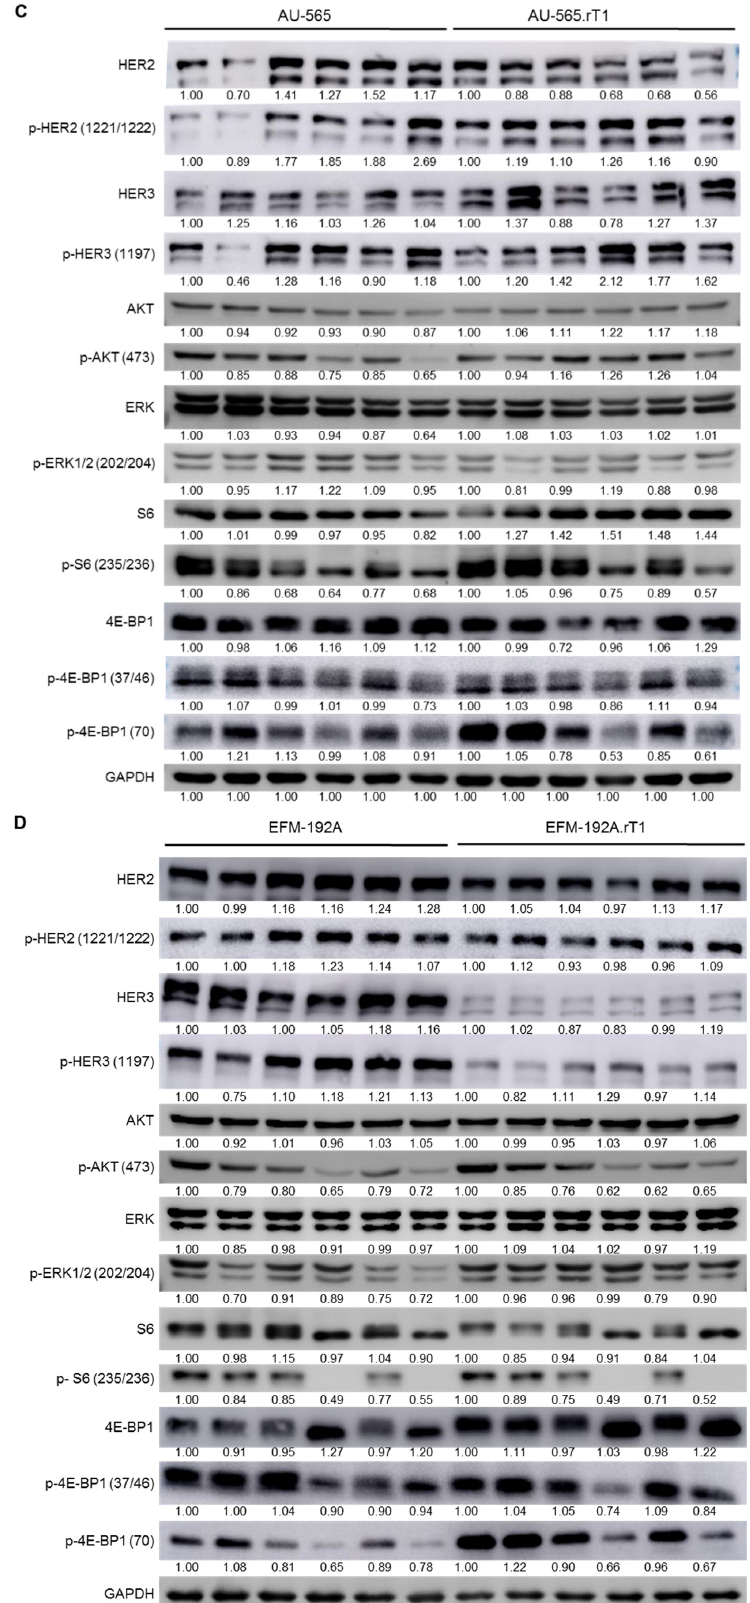
Figure 5. ( A ) Inhibition of p-S6 (Ser235/236) in trastuzumab-sensitive and -resistant BT-474 cells treated with a combination of trastuzumab and TAK-228. Sensitive and trastuzumab-resistant cells were treated for 24 h with DMSO, 15 µg/mL trastuzumab (T), 5 and 50 nM TAK-228 (TAK), or a combination of 15 µg/mL trastuzumab plus 5 or 50 nM TAK-228. Whole-cell protein extracts were analysed with the indicated antibodies. Images are representative of three independent experi- ments. ( B ) Inhibition of p-S6 (Ser235/236) in trastuzumab-sensitive and -resistant SK-BR-3 cells treated with a combination of trastuzumab and TAK-228. Sensitive and trastuzumab-resistant cells were treated for 24 h with DMSO, 15 µg/mL trastuzumab (T), 5 and 50 nM TAK-228 (TAK), or a combination of 15 µg/mL trastuzumab plus 5 or 50 nM TAK-228. Whole-cell protein extracts were analysed with the indicated antibodies. Images are representative of three independent experi- ments. ( C ) Inhibition of p-S6 (Ser235/236) in trastuzumab-sensitive and -resistant AU-565 cells treated with a combination of trastuzumab and TAK-228. Sensitive and trastuzumab-resistant cells were treated for 24 h with DMSO, 15 µg/mL trastuzumab (T), 5 and 50 nM TAK-228 (TAK), or a combination of 15 µg/mL trastuzumab plus 5 or 50 nM TAK-228. Whole-cell protein extracts were analysed with the indicated antibodies. Images are representative of three independent experi- ments. ( D ) Inhibition of p-S6 (Ser235/236) in trastuzumab-sensitive and -resistant EFM-192A cells treated with a combination of trastuzumab and TAK-228. Sensitive and trastuzumab-resistant cells were treated for 24 h with DMSO, 15 µg/mL trastuzumab (T), 5 and 50 nM TAK-228 (TAK), or a combination of 15 µg/mL trastuzumab plus 5 or 50 nM TAK-228. Whole-cell protein extracts were analysed with the indicated antibodies. Images are representative of three independent experi- ments. The molecular effect of TAK-228 on the two lines with primary resistance to trastuzumab (i.e., HCC1954 and JIMT-1) was also studied under the treatment conditions mentioned above. In the presence of combined treatment at both concentrations, the HCC1954 line showed a slight decrease in AKT phosphorylation (Ser473) (Figure S5). It was also observed that p-S6 (Ser235/236) was significantly decreased by treatment with TAK-228 at both concentrations, independent of trastuzumab. The same was true for the